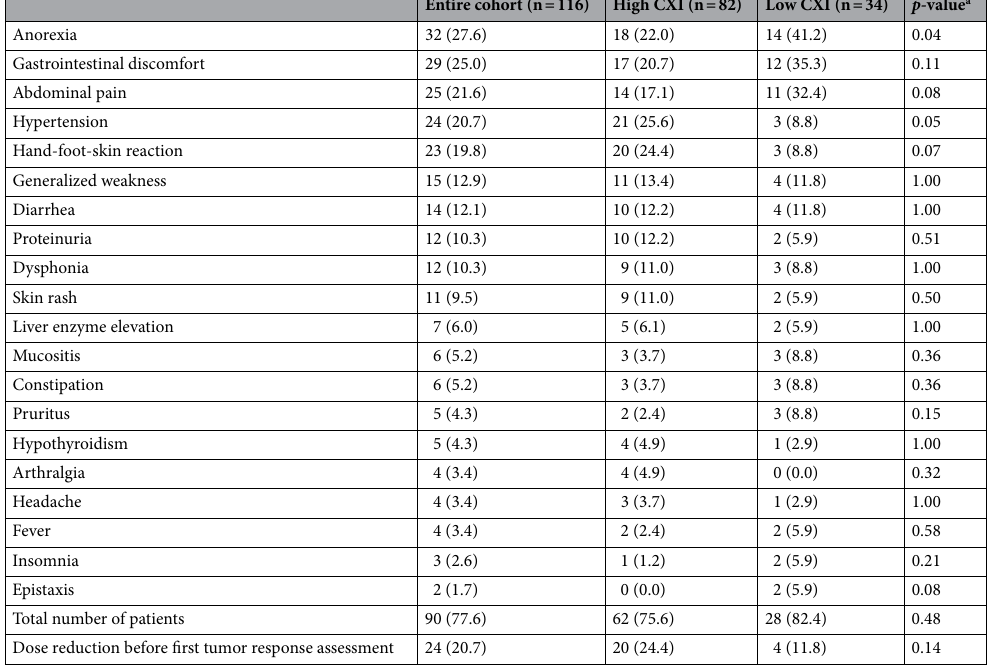
Table 3. Adverse events within the first 2 months. Data are presented as n (%). a P values estimated by χ 2